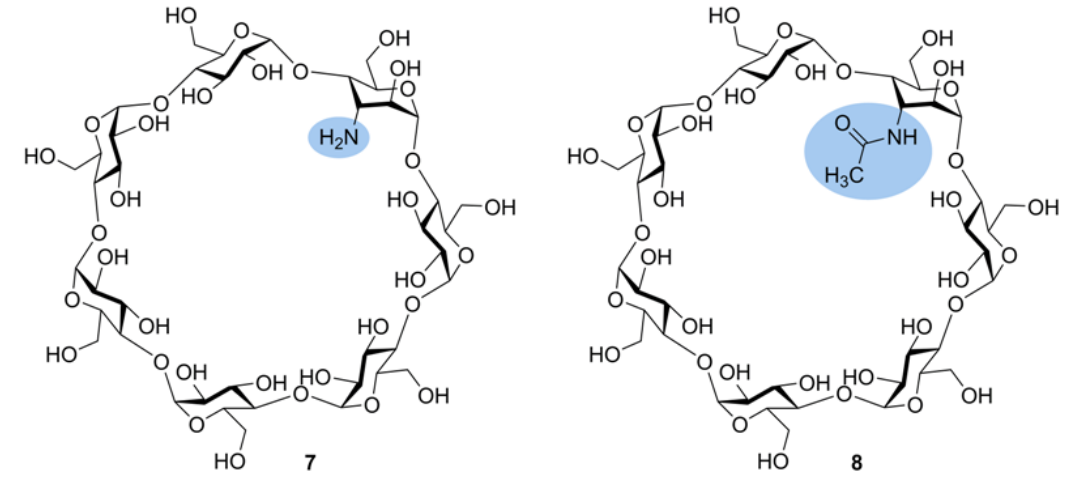
Figure 7. Structural formulas of monosubstituted 3-amino β -CD 7 and 3-acetamido β -CD 8 [55]. Nitrogen-containing functional groups are highlighted.